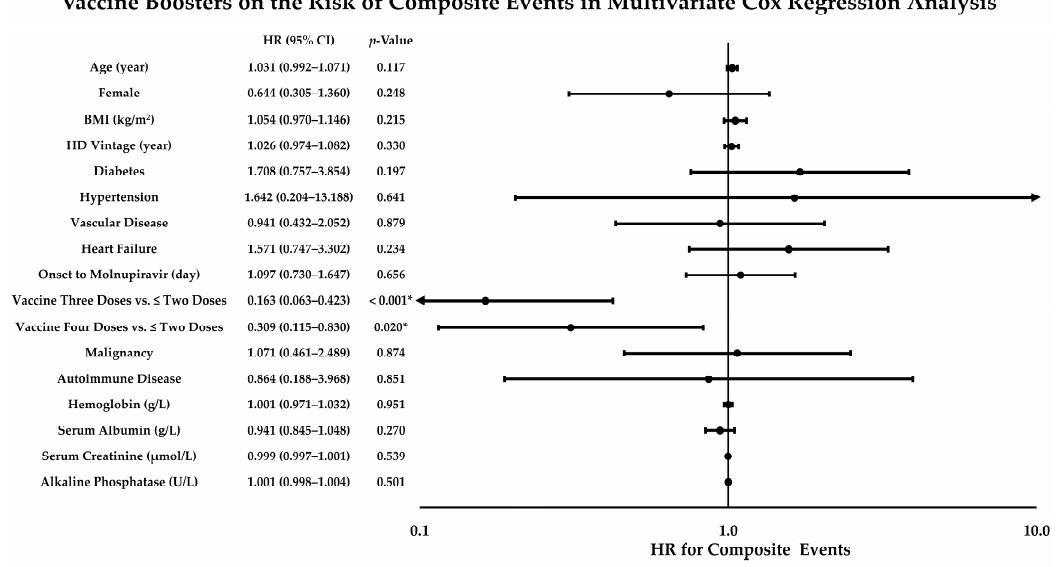
Figure 4. Effects of Vaccine Boosters on Decreasing the Risk of Composite Events in HD Patients with Initially Mild or Asymptomatic COVID-19 Receiving Molnupiravir. Multivariate Cox regression analysis was performed to evaluate the effects of vaccine boosters on the risk of composite events within 30 days of COVID-19 onset, adjusting for age, sex, BMI, HD vintage, diabetes, hypertension, vascular disease, heart failure, interval between COVID-19 onset and molnupiravir initiation, and covariates with a p -value < 0.1 in the univariate analyses via the enter method. BMI, body mass index; CI, confidence interval; HR, hazard ratio. *: p <